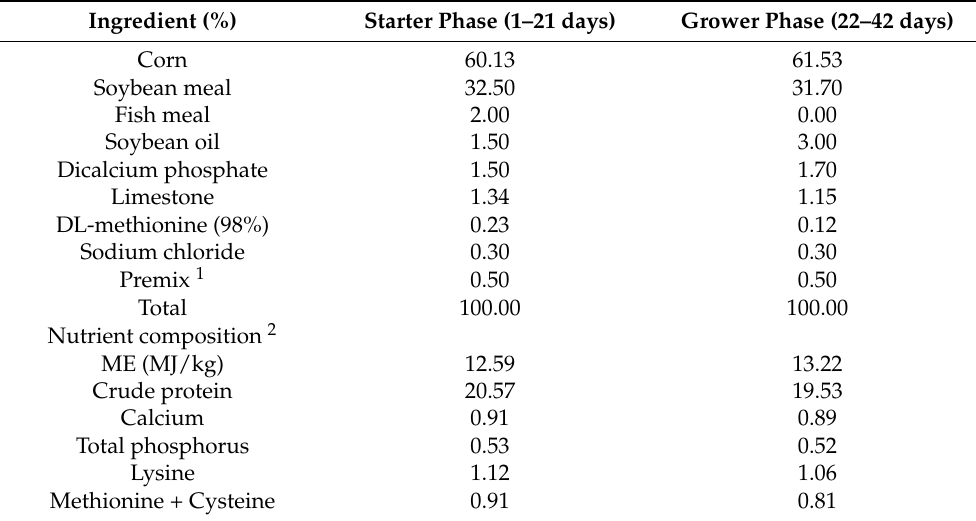
Table 1. Ingredient composition and nutrient composition of basal diets (%, as-fed